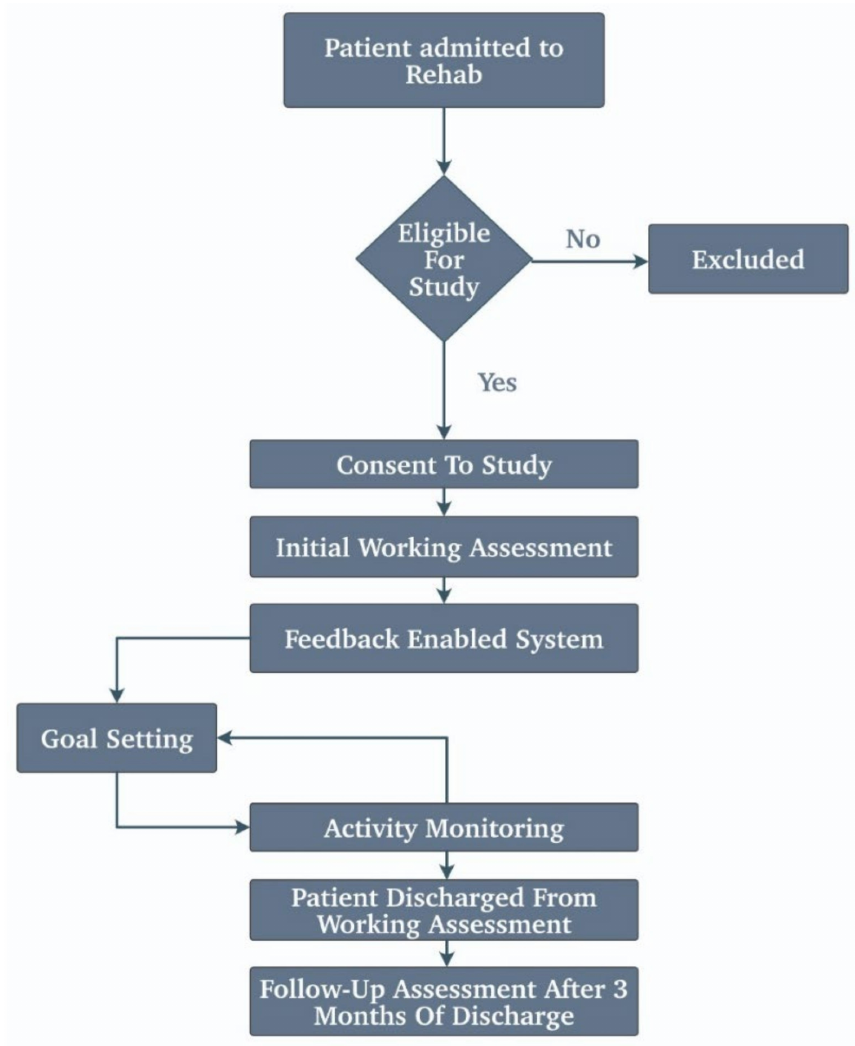
Figure 7. The algorithm used for stroke rehabilitation (recovery of motor